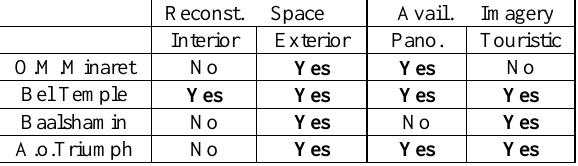
Table 1. The space to reconstruct and the available imagery for every reconstructed monument.